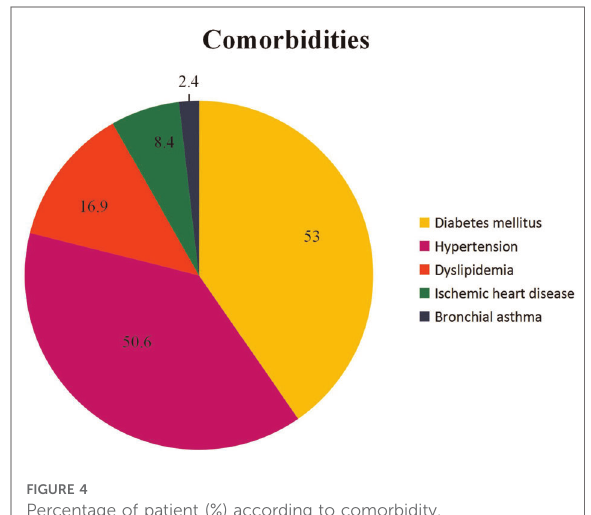
FIGURE 4 Percentage of patient (%) according to comorbidity.